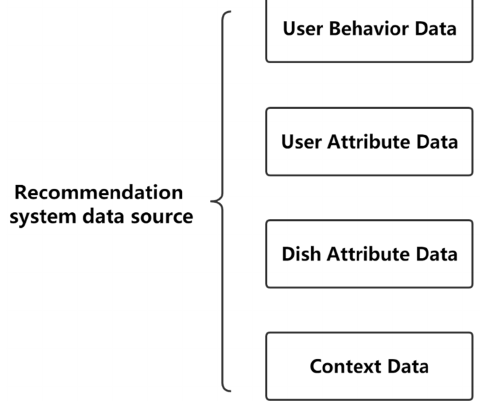
Figure 26. Recommendation algorithm data source.